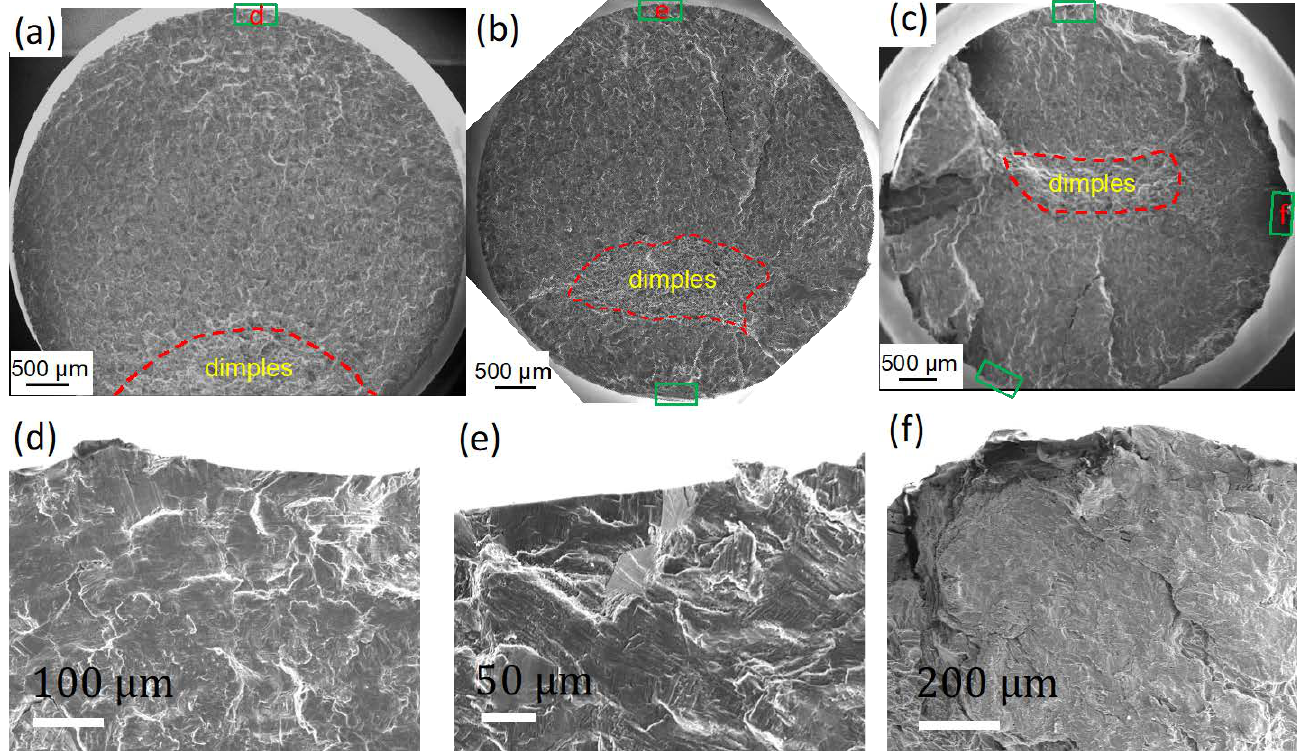
Figure 6. Fractography of the samples tested at ( a ) 175, ( b ) 200, and ( c ) 227 MPa. Green boxes indicate the nucleation sites of the main cracks. Crack nucleation sites for ( d ) 175, ( e ) 200, and ( f ) 227 MPa stress conditions.